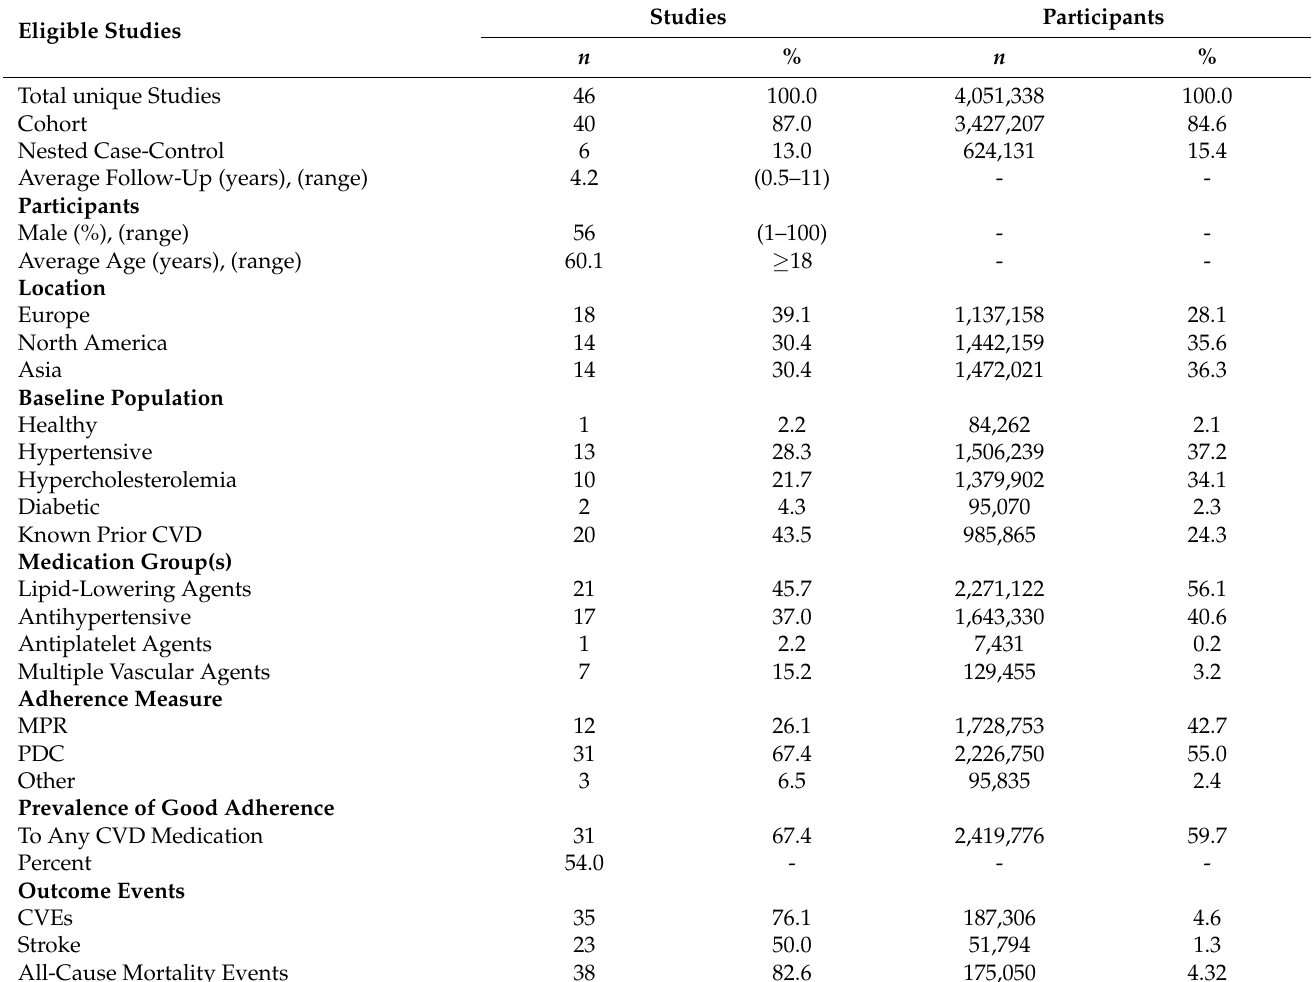
Table 1. Summary characteristics of the unique studies included in this